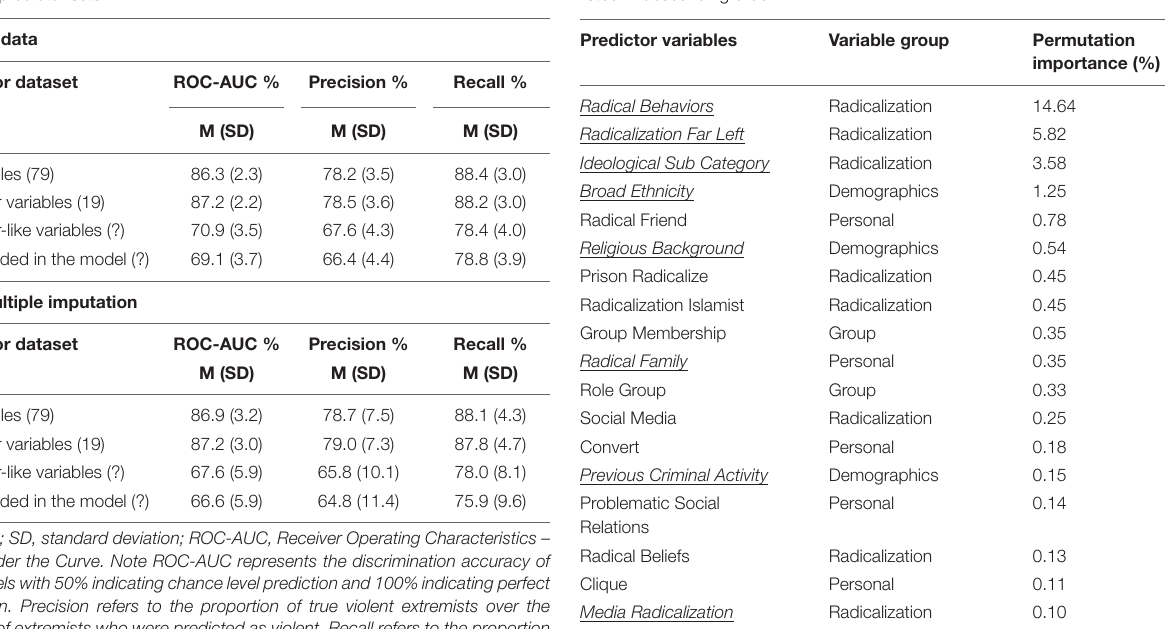
TABLE 5 | Average permutation importance of the 19 most important predictors listed in descending